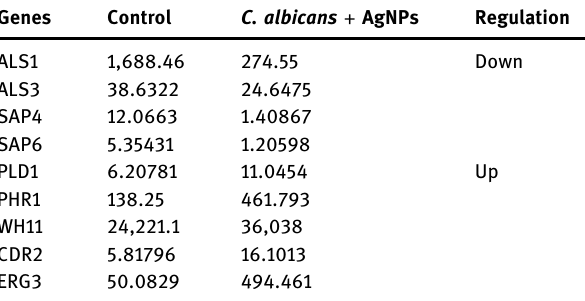
Table 2: Genes of interest, di ff erential expression gene is repre - sented in fragments per kilo base of transcript per million mapped fragments ( FPKM ) comparing control group vs experimental group